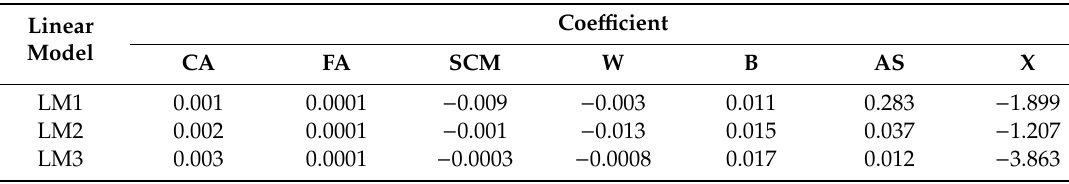
Table A3. Input coe ffi cients of M5p for FS